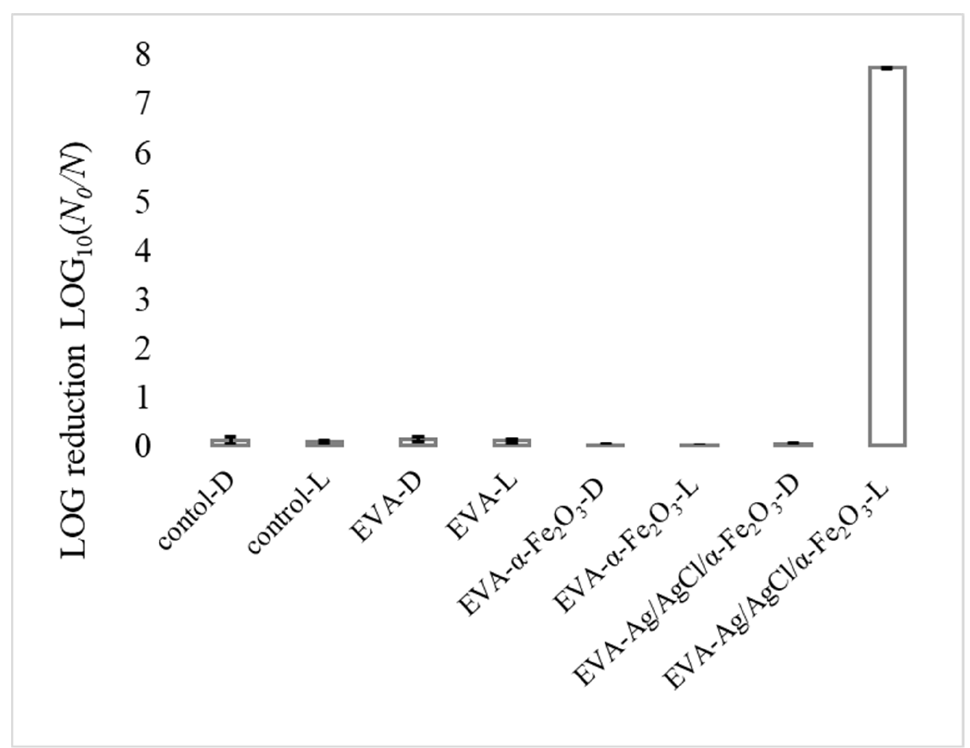
Figure 4. Antibacterial efficiency of EVA-, EVA-α-Fe 2 O 3 , and EVA-Ag/AgCl/α-Fe 2 O 3 coated surfaces towards S. aureus in the dark [D], and upon visible-light illumination [L] for 30 min. Image (B) graph shows log reduction values. The mean value of 2 repetitions with 3 samples in each ± standard deviation (SD) is reported.